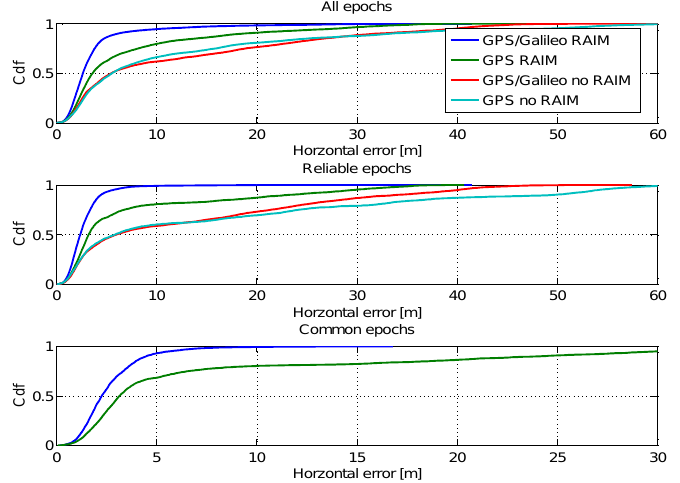
Figure 10. CDFs of the horizontal errors. Upper box: CDFs of the horizontal position errors computed using all epochs; central box: CDFs computed using only the reliable epochs; lower box: CDFs computed using only common